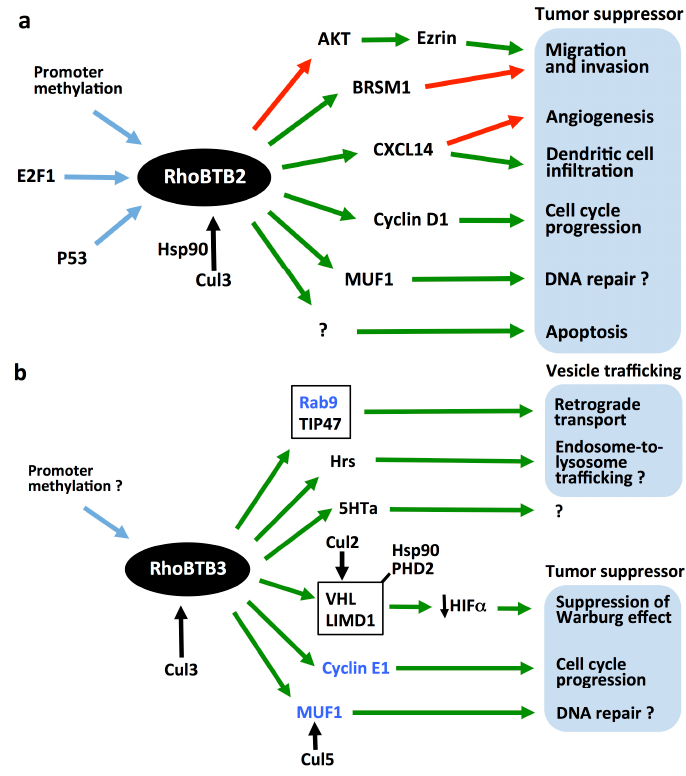
Figure 2. Schematic illustrating the roles of RhoBTB proteins in tumorigenesis and other processes. Proposed mechanisms for ( a ) RhoBTB2 and ( b ) RhoBTB3 are shown. RhoBTB1 (not depicted) is likely to function similarly to RhoBTB2 but has not been investigated extensively. Blue arrows indicate factors that affect the expression of the RhoBTB-encoding gene. Green arrows indicate positive or stimulatory links. Red arrows indicate inhibitory links. Interacting cullins are indicated with black arrows. The arrows do not implicate direct interactions; see Table 1 for details on interactions. Recognized substrates of RhoBTB3-dependent ubiquitin ligase complexes are shown in blue. Multiprotein complexes are boxed. Table 1. Interaction partners of RhoBTB and their functions. The technique used to identify the interaction is given in brackets. B2H, bacterial two hybrid; CL, chemical crosslinking; IP: immunoprecipitation; IVEC, in vitro expression cloning followed by GST pull-down; Y2H, yeast two-hybrid. Note that some interactions included in the table, particularly those found using only immunoprecipitation, are not necessarily direct interactions. The RhoBTB3/LIMD1-PHD2-VHL-HIF α complex and the RhoBTB2/Hsp90 complex have not been investigated in detail in terms of direct interactions. Hsp90 is part of the above RhoBTB3 complex, but through PHD2, not directly. Hsp90 chaperone refers to Hsp90 and co-chaperone components. Note also that RhoBTB proteins are capable of homo and heterodimerization.